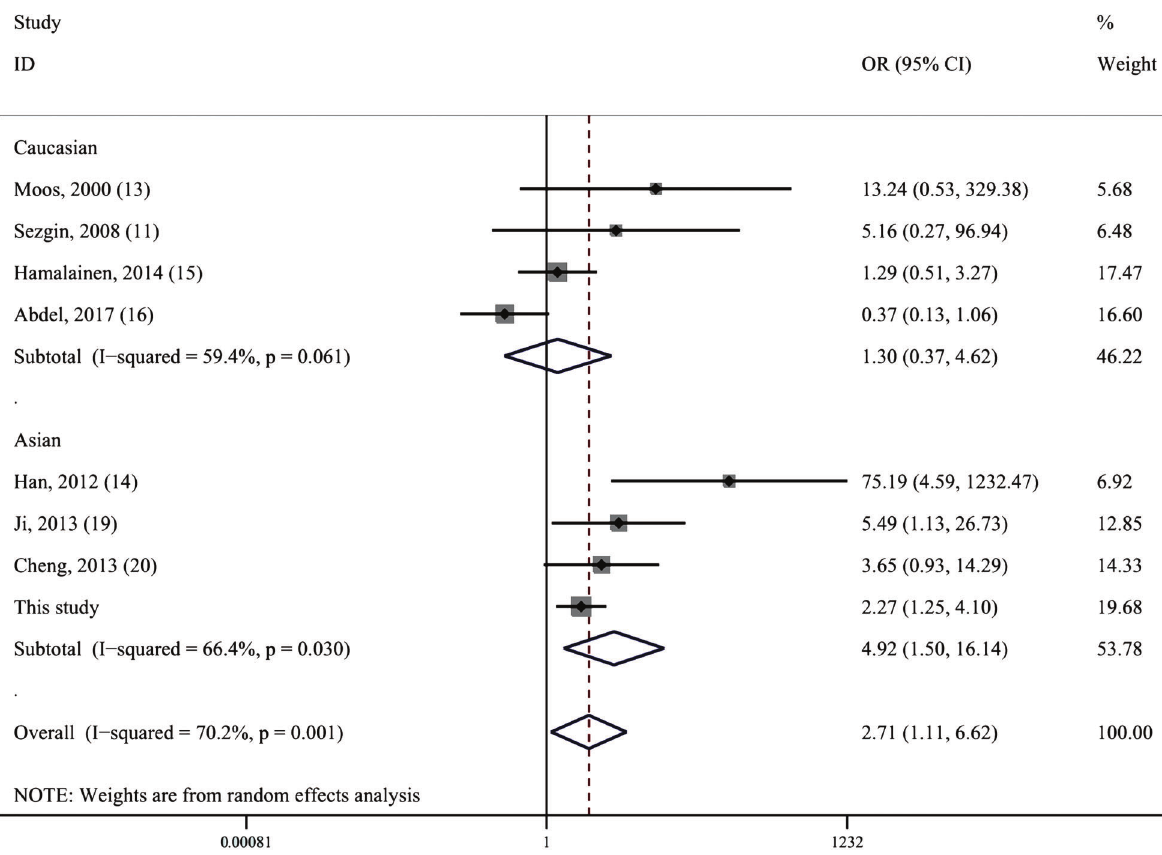
Figure 2. Strati fi cation analyses of ethnicity between rs1800629 polymorphism and osteoarthritis risk (AA vs GA +